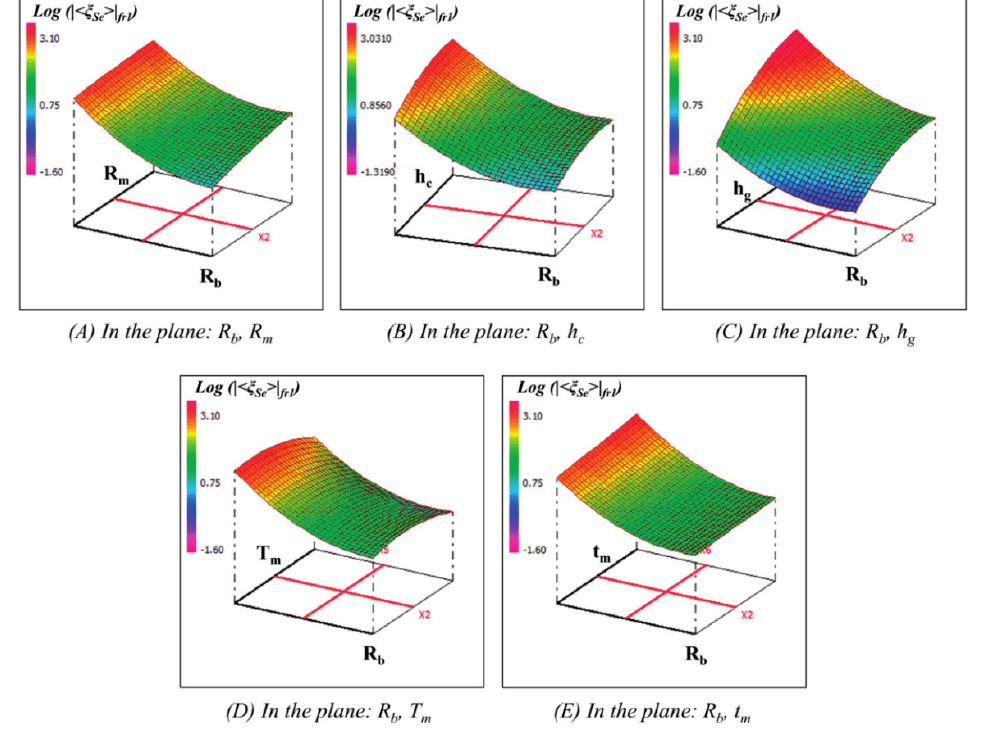
Figure 7. Response surface plots of logarithm of maximum membrane displacement at first resonance frequency (Log (| ˂ξ Se ˃ | fr1 )) in different planes with respect to other factors kept constants at the central